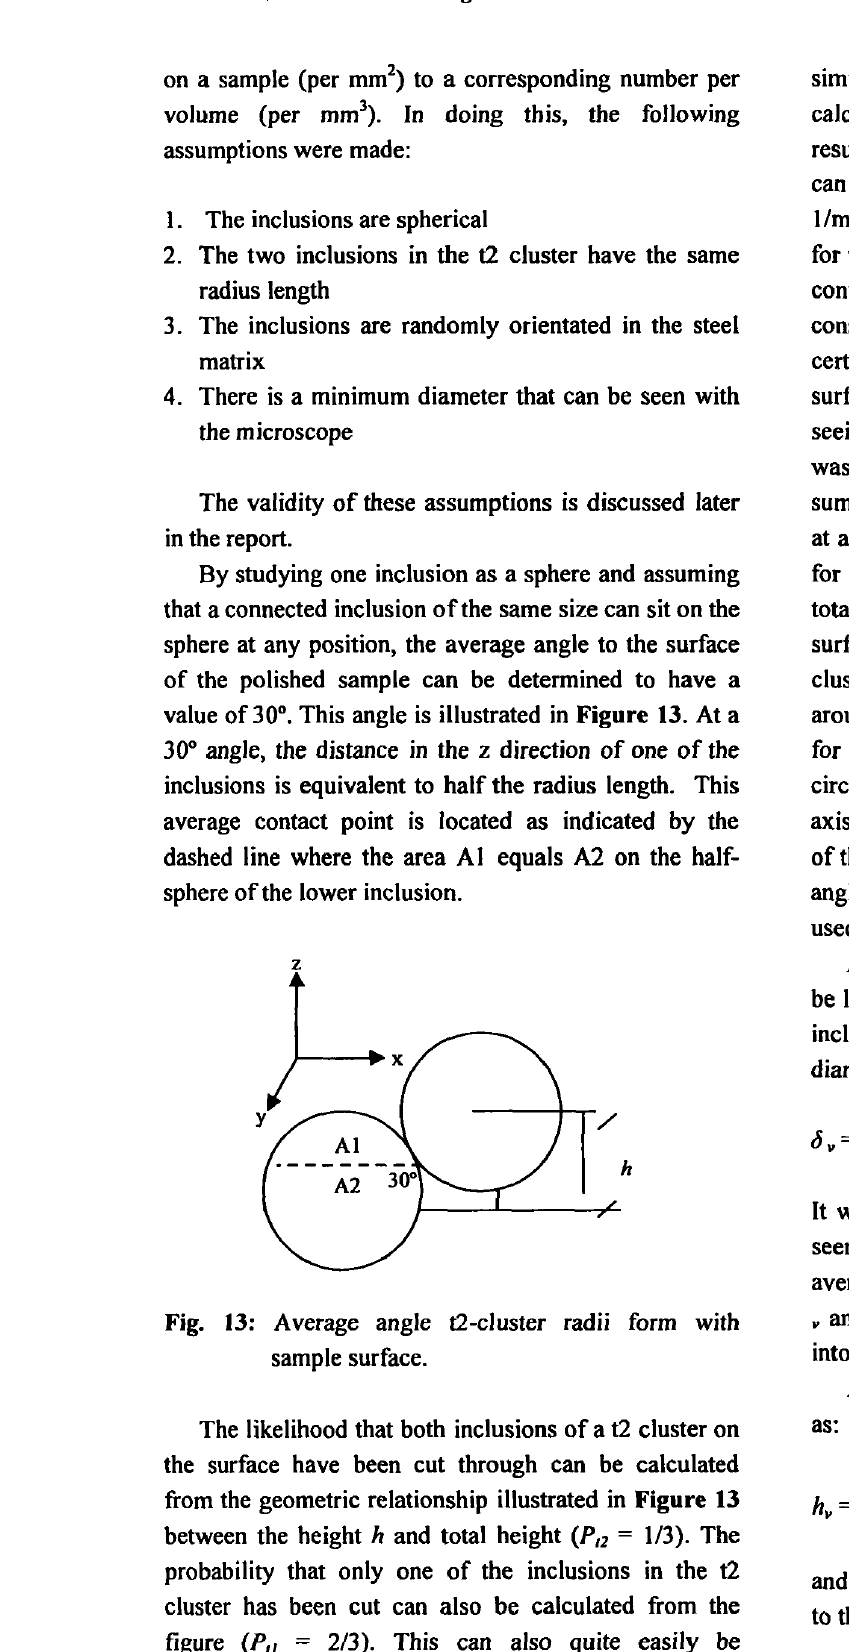
Fig. 13: Average angle t2-cluster radii form with sample